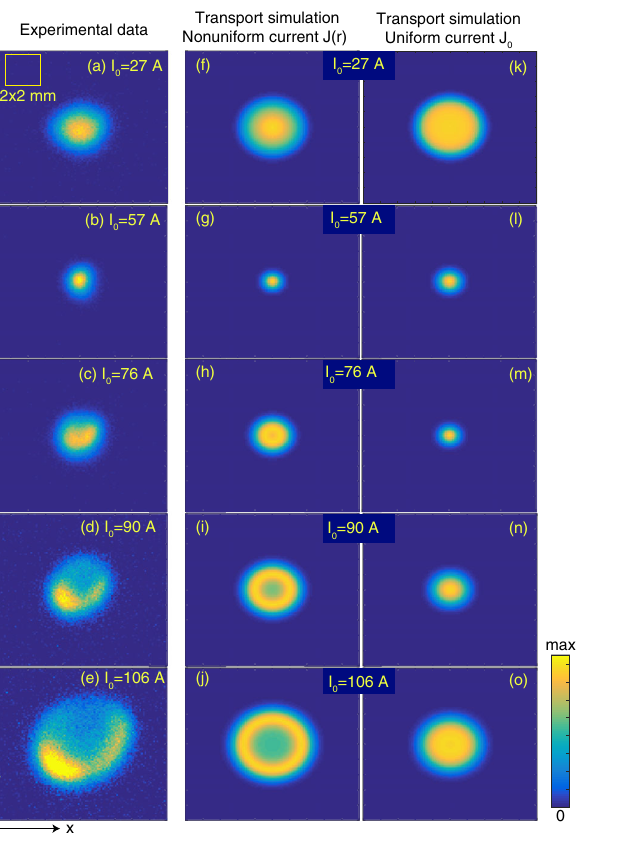
FIG. 4. Charge distribution on the phosphor screen at various discharge timings (and thus discharge currents). Experimental data in (a) – (e), simulations based on a plasma lens with nonuniform current in (f) – (j), and uniform current in (k) – (o). For overfocusing currents ( > 60 A), the nonuniform current simulations (h) – (j) match the observed ring-shape beam profiles, while for the underfocused current of 27 A the beam profile is filled in for both experiment (a) and simulation